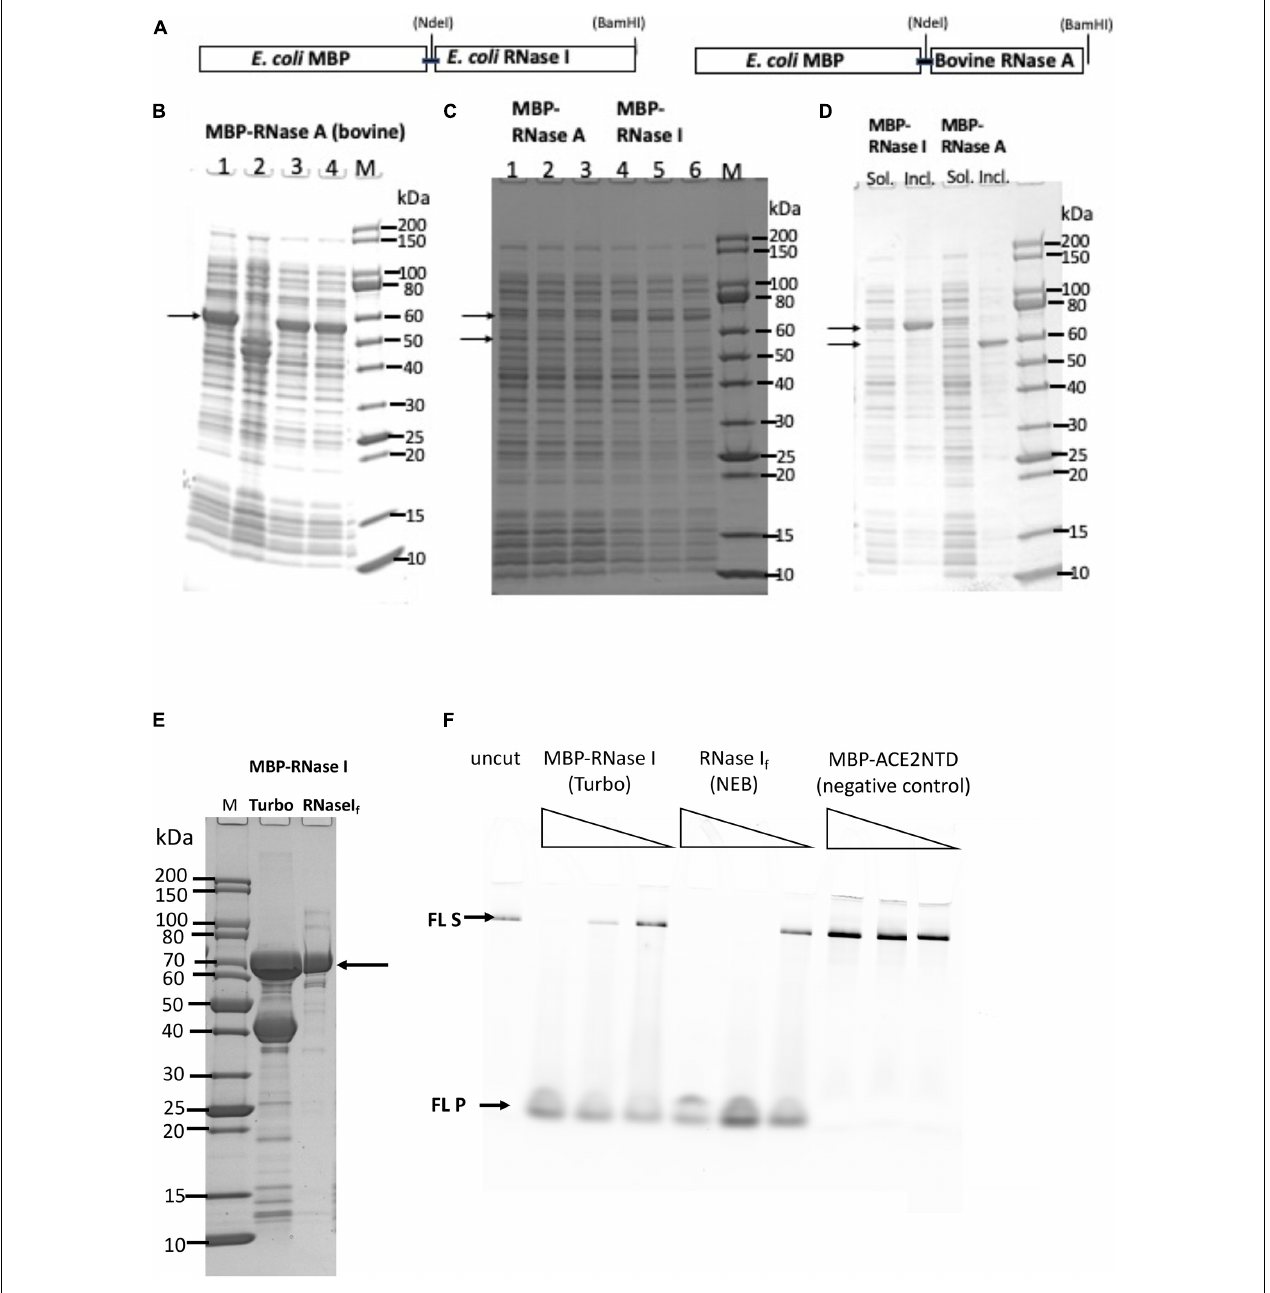
FIGURE 2 | SDS-PAGE analysis of MBP-RNase I and MBP-RNase A fusions. (A) Schematic diagram of MBP-RNase fusion. (B) Total cellular proteins from IPTG-induced cells (NEB Express). (C) Supernatant (soluble) of the fusion proteins (three independent isolates each). Arrows indicate the fusions. (D) Comparison of supernatant (Sol.) and pellet (Incl.) of the fusions. M, protein size marker (NEB). (E) SDS-PAGE analysis of partially purified MBP-RNase I fusion. Lane 1, protein size marker; lane 2, MBP-RNase I fusion purified from IPTG-induced NEB Turbo cells (C2984); lane 3, RNase I f (NEB). (F) RNase activity on fluorescein-labeled RNA (300 nt). No enzyme (uncut) and MBP-ACE2NTD fusion serve as negative controls. S, substrate; P,